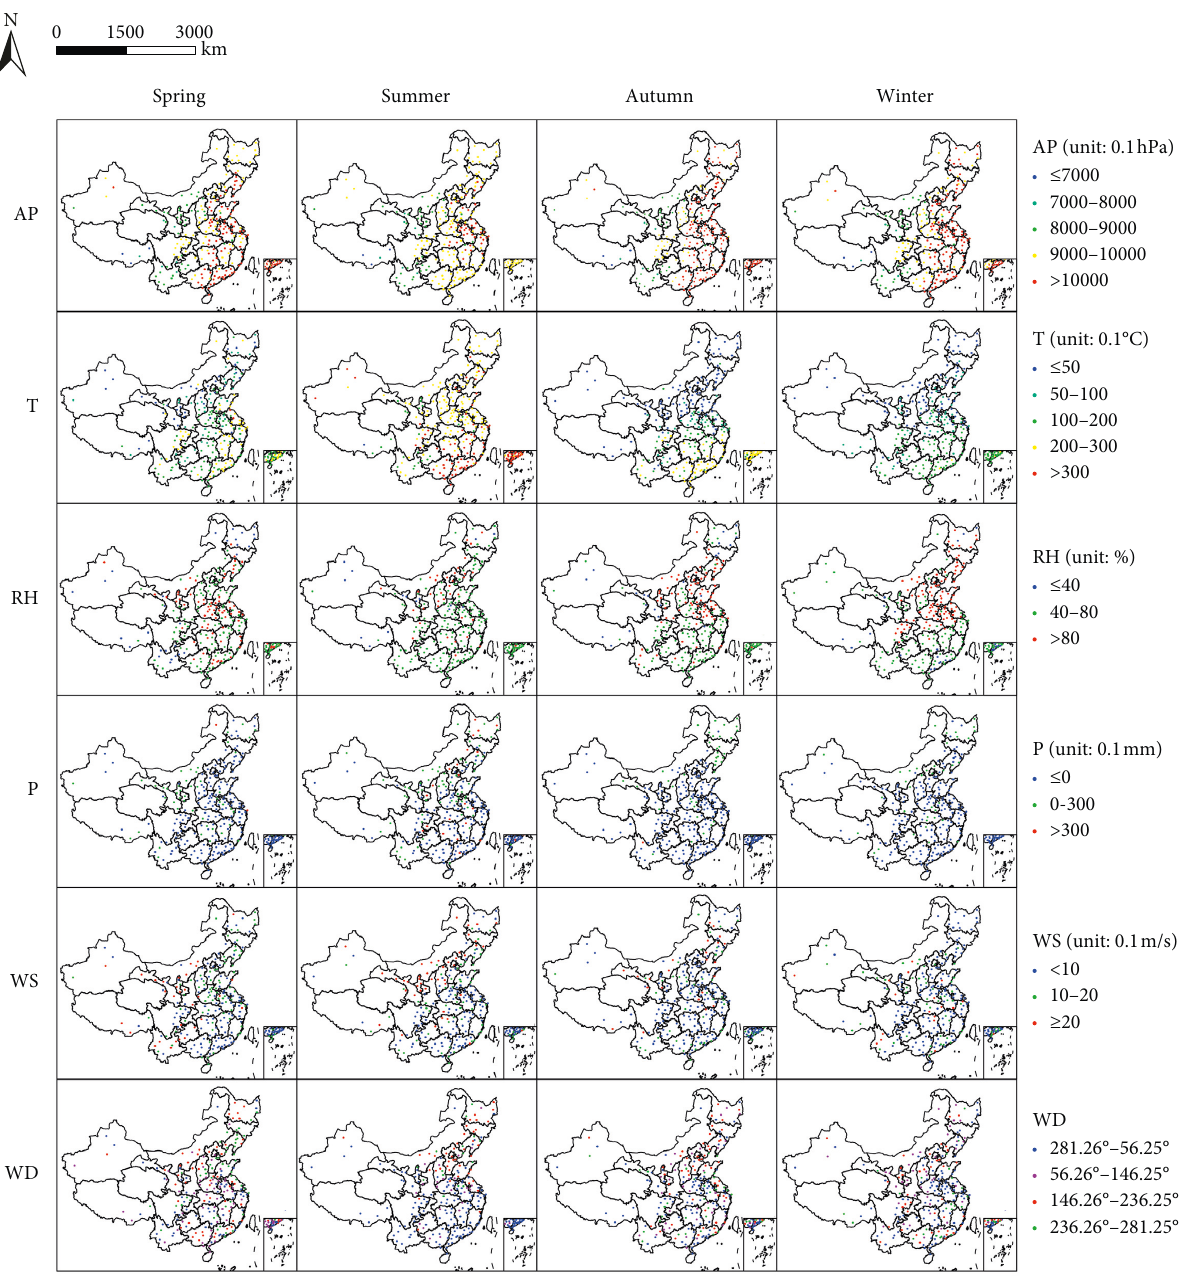
Figure 16: Spatial pattern of the impact of meteorological factors on PM